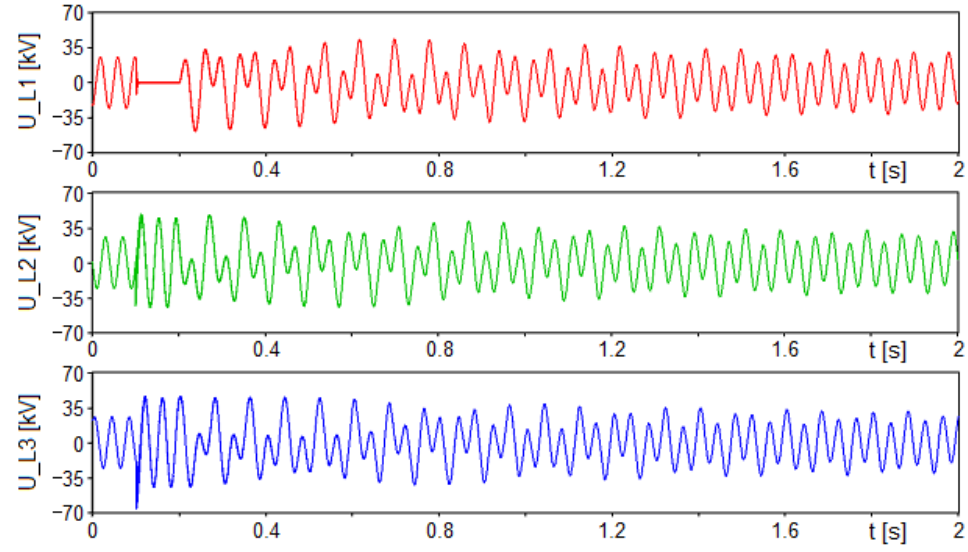
Figure 8. Phase voltage waveforms on the primary side of voltage transformers as a result of changing their magnetization characteristics from 2 to 3.